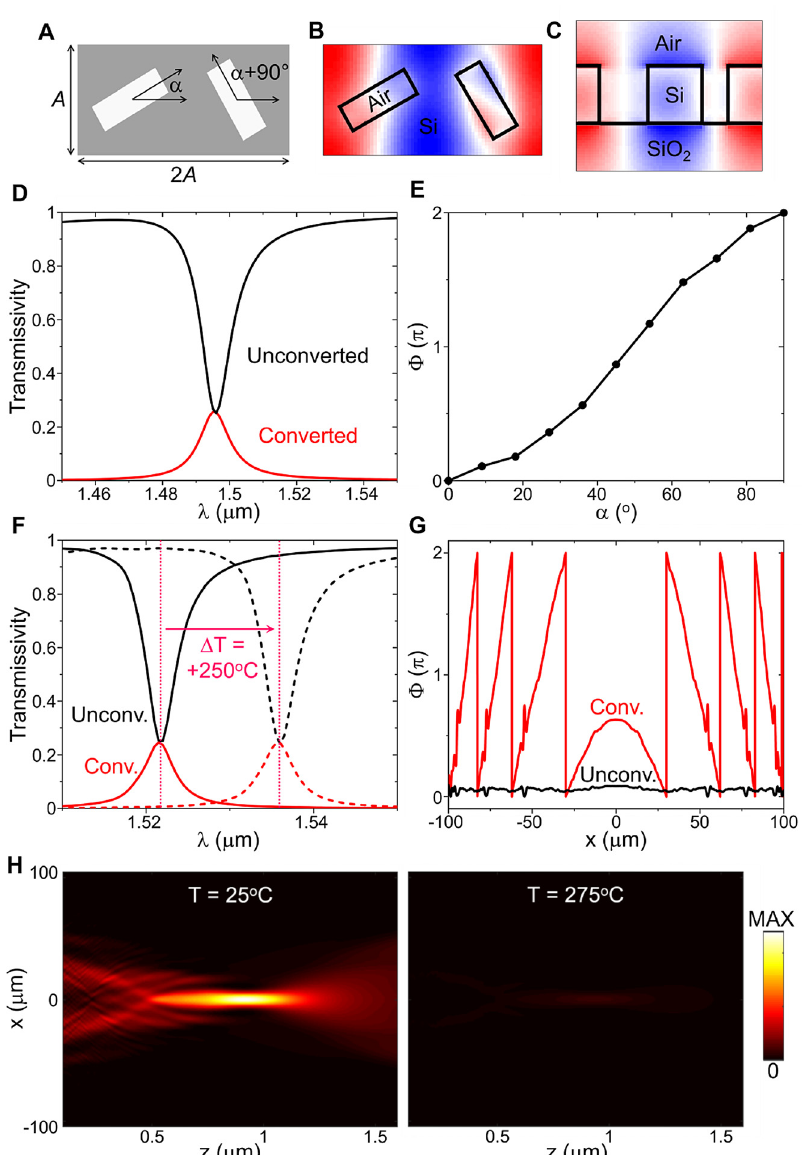
unpatterned substrate. We have previously demonstrated With this meta-unit library, we create a cylindrical experimentally that nonlocal metasurfaces with distinct metalens with a numerical aperture (NA) of 0.1 and a resonant wavelengths can be cascaded to achieve multi- functional behavior [26]. Cascaded and independently tunable nonlocal metasurface modulators could enable multifunctional switchable behavior by tuning the reso- nance of each metasurface to be aligned or misaligned with the narrowband incident light (Figure 1B). We caution that (Figure 4F). Simulated far- fi eld distributions of the metal- aligning the resonances of multiple cascaded metasurfaces ens at λ = 1521 nm (Figure 4H) demonstrate that the device to the narrowband incident light does not provide a acts as a lens at 25 ° C but not at 275 ° C, where little light of meaningful use case on account of its low ef fi ciency as converted handedness is transmitted. Hence for narrow- each metasurface can transmit only ∼ 25% of the incident band incident light, the device exhibits thermally switch- light on resonance for each circular polarization. able functionalities between that of a lens and that of an